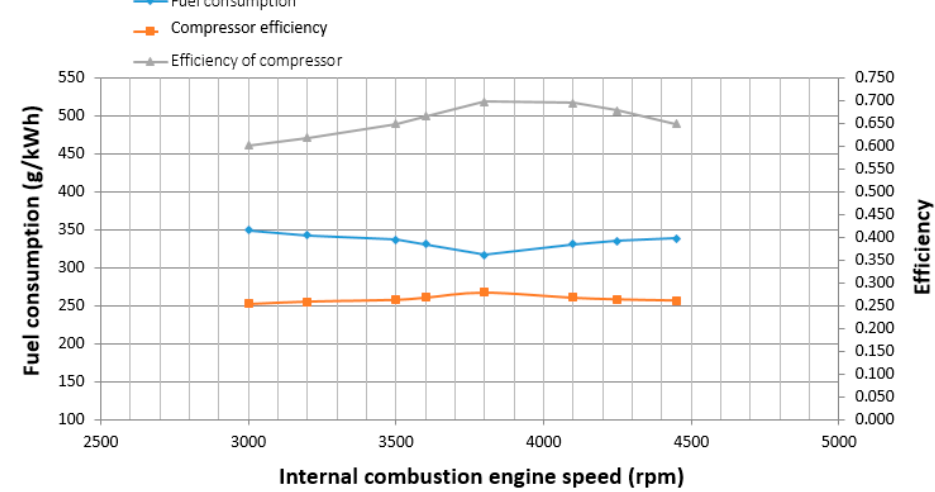
Figure 12. Relationship between the ICE speed, fuel consumption, ICE efficiency, and compressor efficiency.